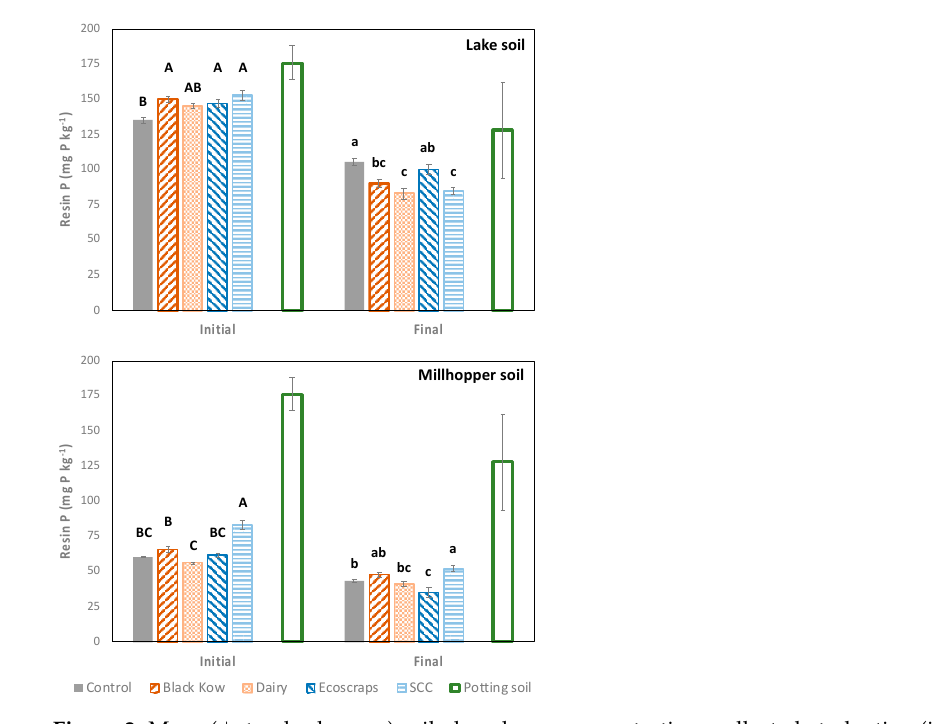
mg P kg − 1 ) compared to the control (135 mg P kg − 1 , Figure 2, p = 0.002). Soil P decreased